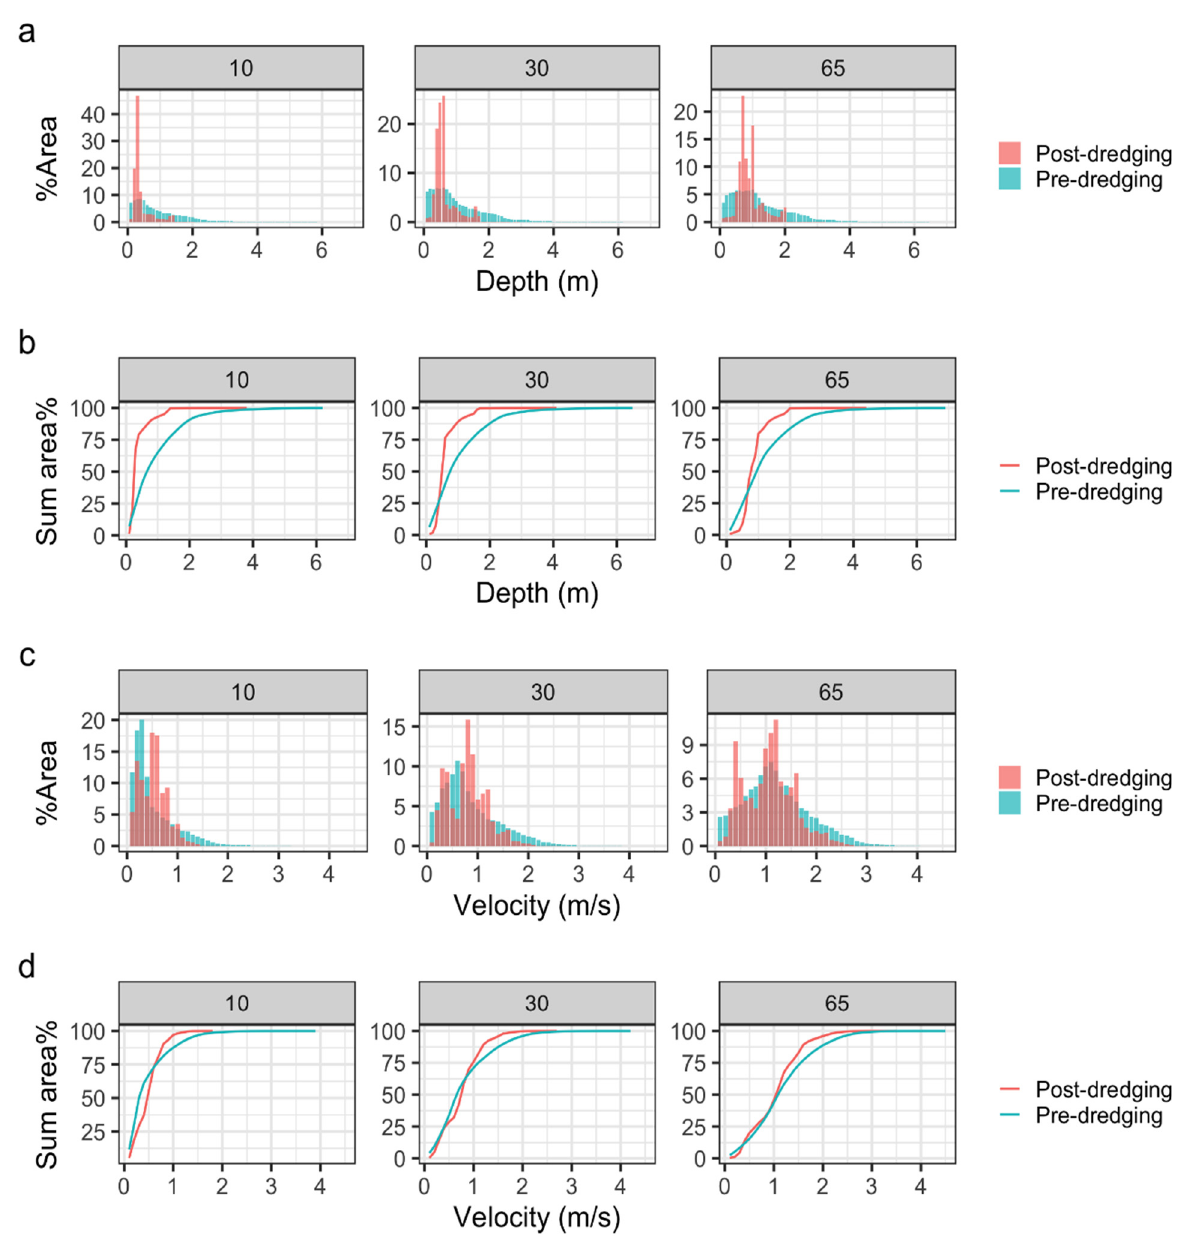
Figure 7. Histogram in % ( a , c ) and accumulated area in % ( b , d ) for depth and velocities at low, average, and high flows (10, 30, and 65 m 3 /s).